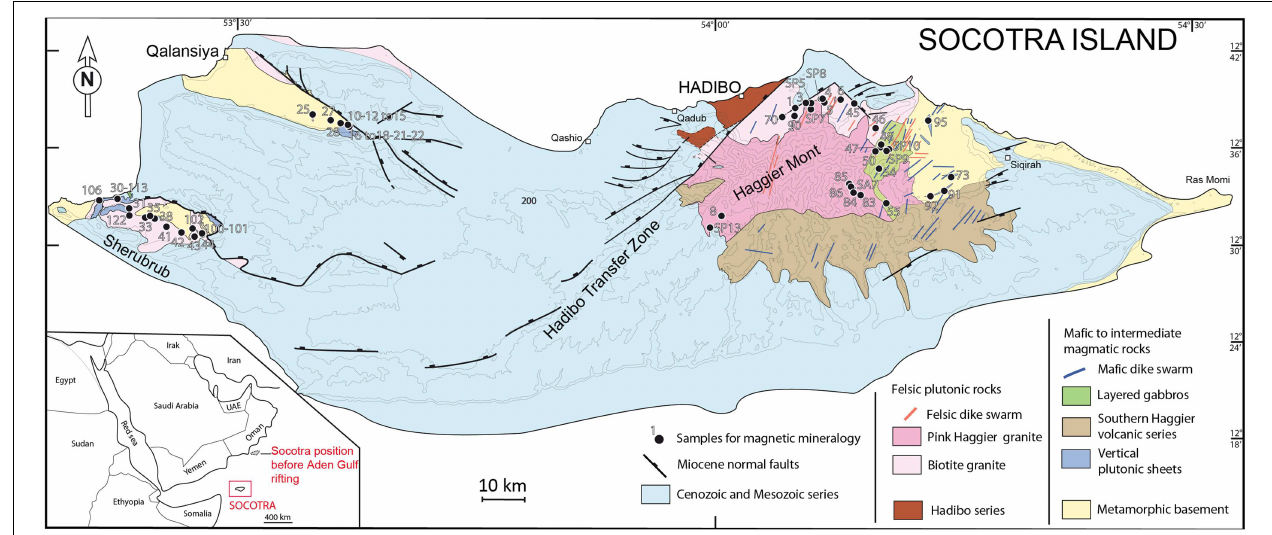
FIGURE 3 | Geological map of Socotra (modified from Denéle et al., 2012), locating the different samples accross the Neoproterozoic basement.